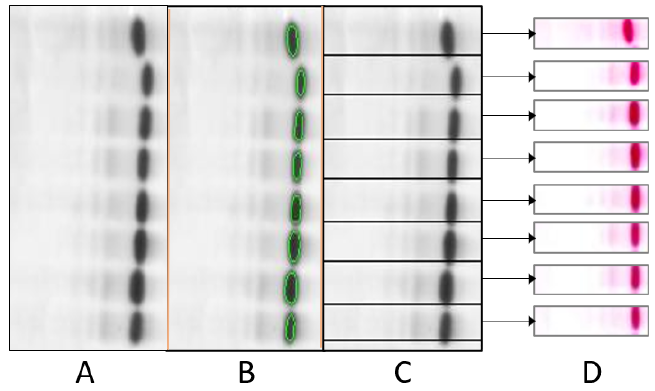
Figure 7. Pre-processing techniques of grayscale images for lane extraction: ( A ) grayscale image, ( B ) connected object detection, ( C ) extracted lane images and ( D ) cropped images.